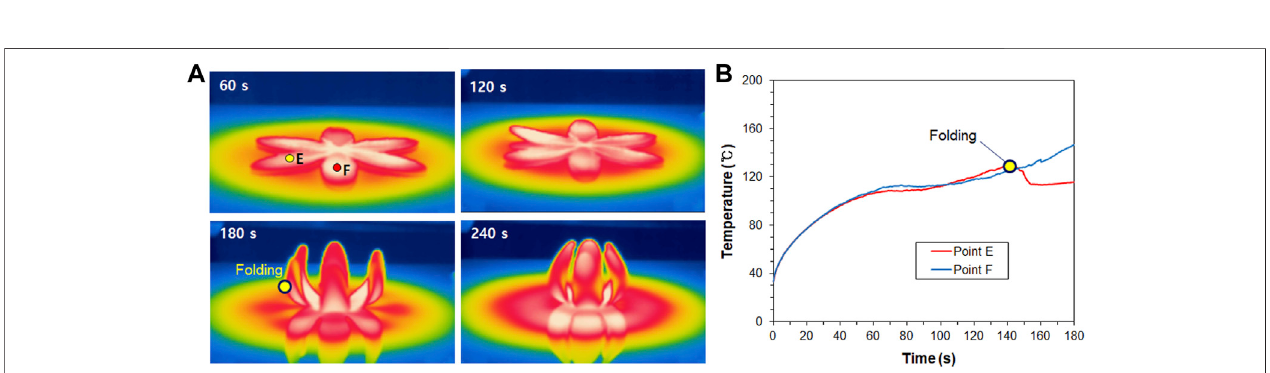
FIGURE 10 | Global shape transformation of the 2D fl ower-shape plate (A) Deformations and the relevant temperature changes (B) Comparison of temperature pro fi les at points E and F.